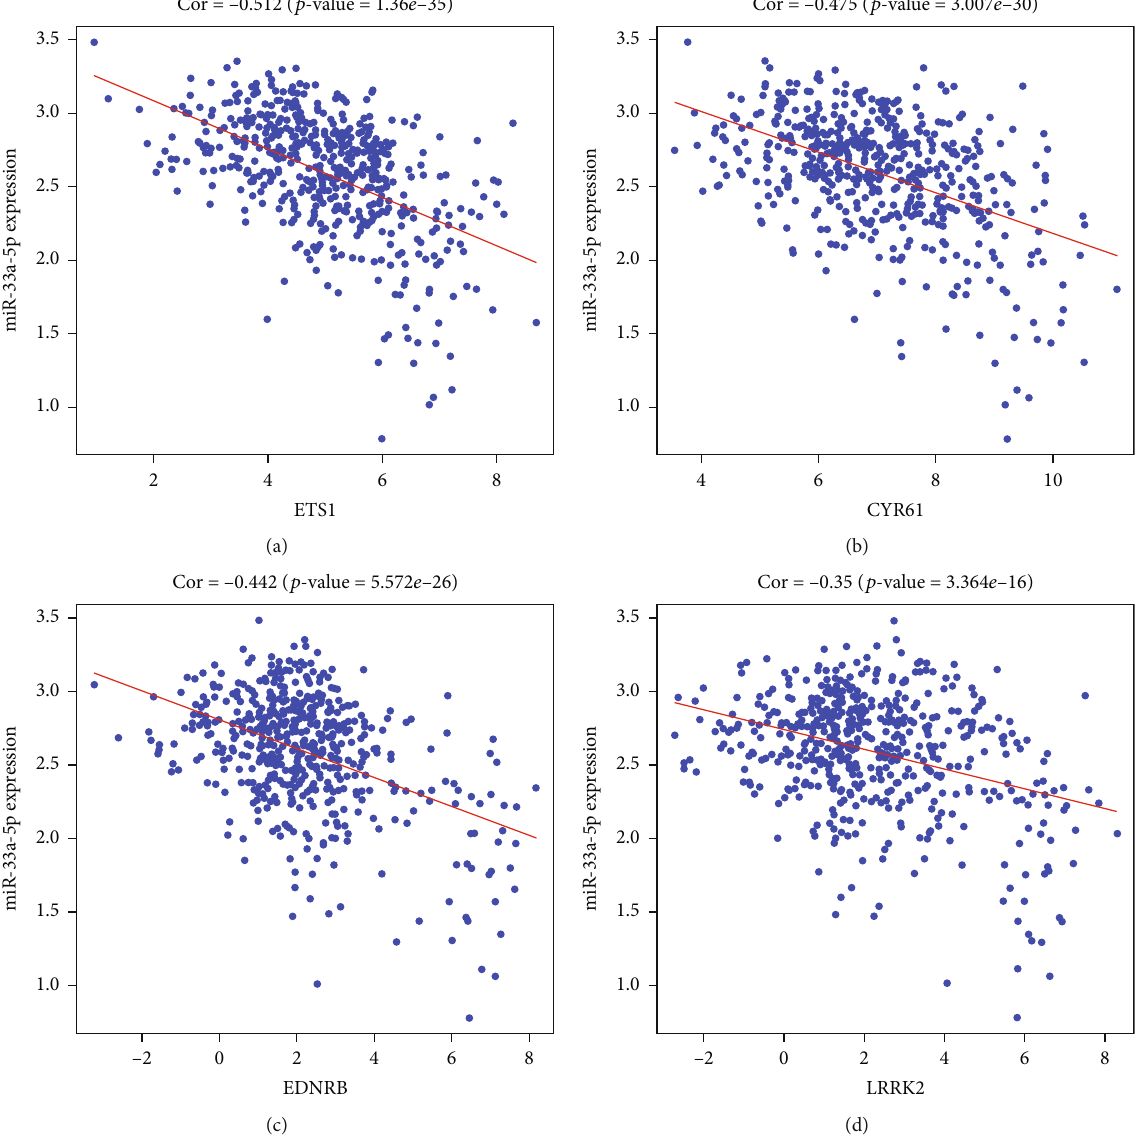
Figure 12: Pearson ’ s correlation analysis of miRNA-33a-5p expression and the expression of the four prognosis-related hub genes. (a – d) Correlations between miRNA-33a-5p and ETS1, CYR61, EDNRB, and LRRK2, respectively. P < 0 : 05 indicated statistical signi fi